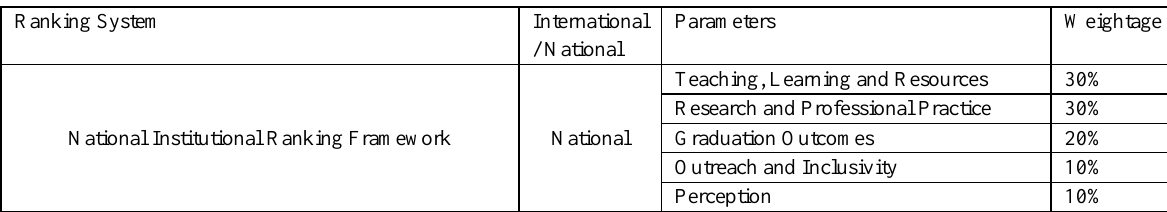
Table2. NIRF ranking parameters with their